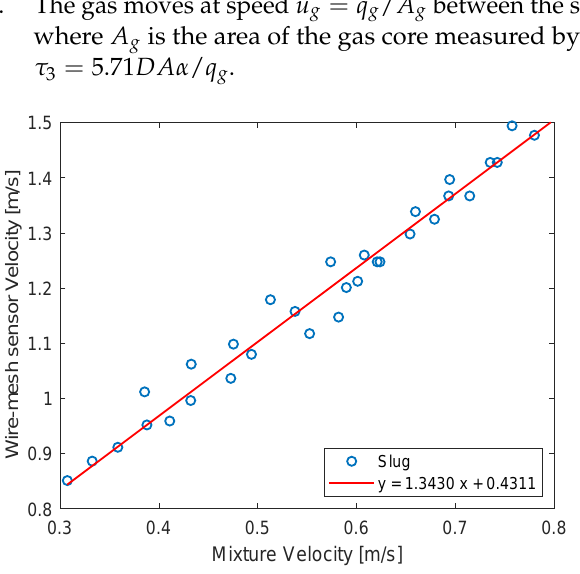
Figure A1. Comparison between the gas velocity and the mixture velocity in the WMS location for slug flows. The flow rate of air used in the calculation of the mixture velocity is obtained from the mass flow rate injected in the system and pressure measurements near the WMS.